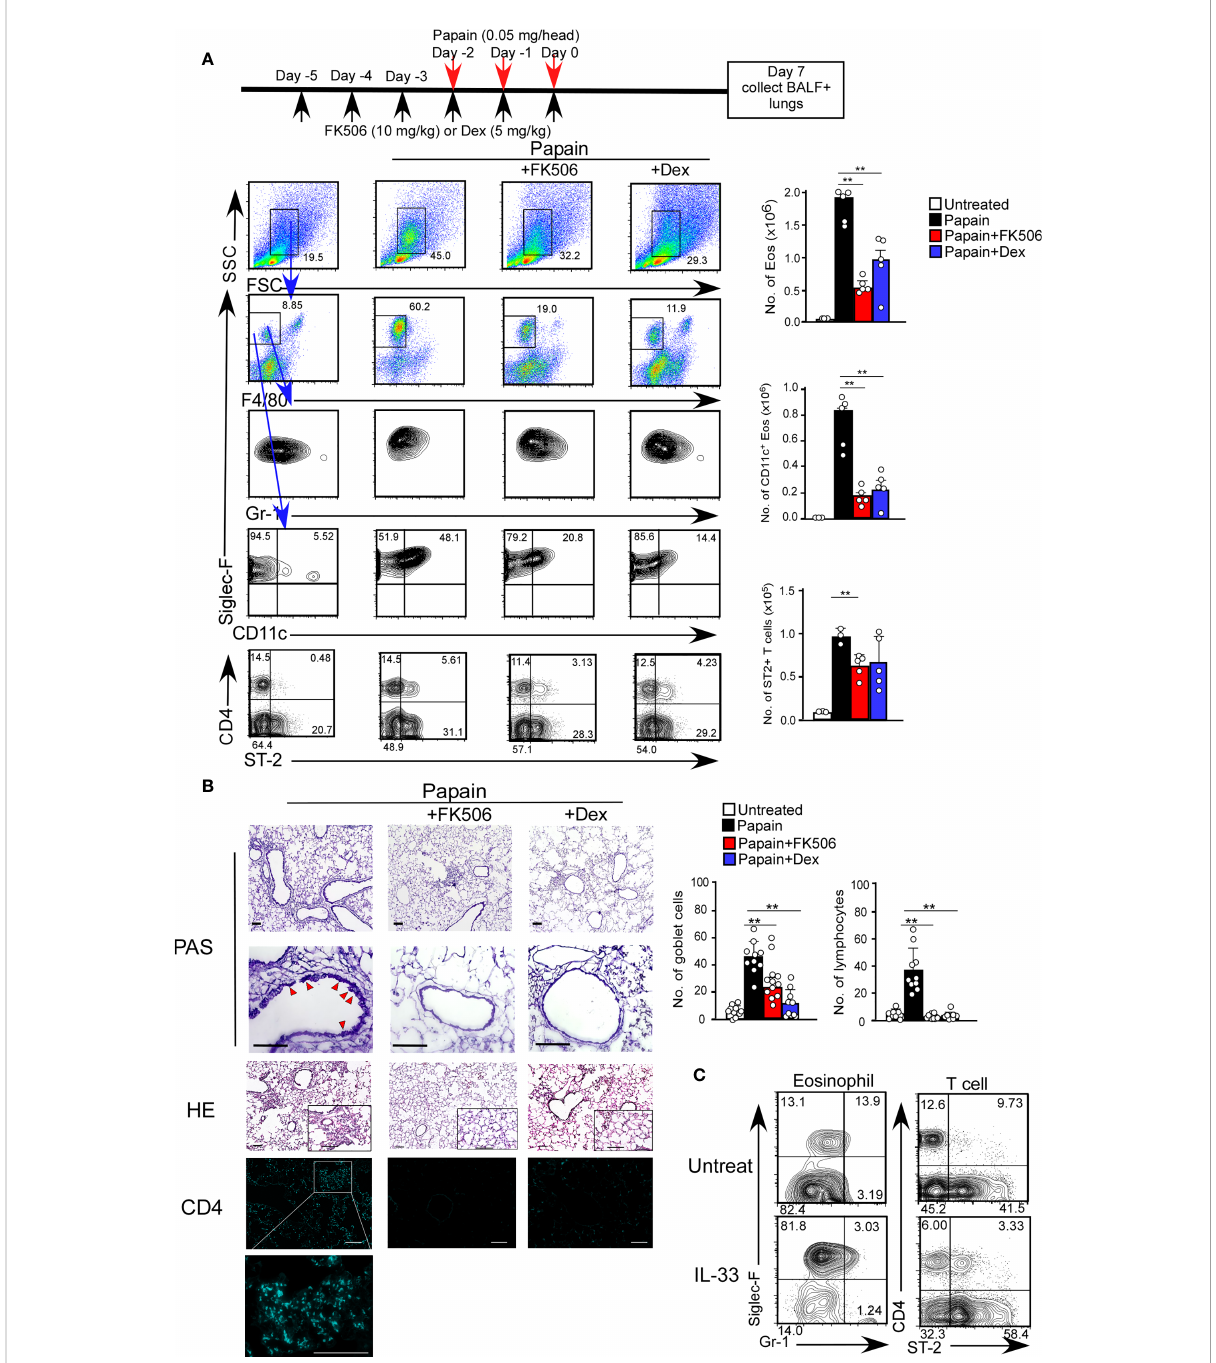
FIGURE 2 FK506 inhibited protease allergen-induced T cell-mediated airway in fl ammation. (A) The papain and FK506 or Dex treatment protocol is presented by the schematic diagram (top). Lung cells from papain-administrated mice (black bars, n=5) treated with FK506 (red bars, n=5) or Dex (blue bars, n=5) were harvested on day seven. (B) PAS + Goblet cells (top: low magni fi cation; second from top: high magni fi cation) and Eos (HE, second from bottom), and CD4 + T cells (bottom, right blue) were stained in lung sections at day seven, and were analyzed by fl uorescence microscopy (low magni fi cation, x20; high magni fi cation, x100; Scale bars, 100 µm). Goblet cells and lymphocytes were counted in 200 µm × 200 µm regions in each lung section (bar graphs, n=10). Red arrow heads indicate mucus glycans positive goblet cells. (C) The mice were administrated with mrIL-33 (1 µg/head/day). Lung cells were harvested on day four, and the proportions (left fl ow pro fi les) and cell numbers (right graph) of Siglec-F + and CD11c + Eos and ST-2 + CD4 + T cells were assessed. Bars represent means; **p<0.01 using unpaired Mann-Whitney U-tests. All error bars represent SEM. FACS and section data are representative of three